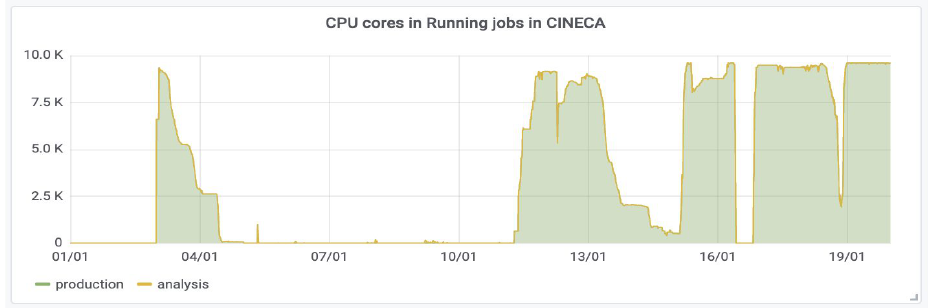
Fig. 3. Number of cores running for CMS in the period Dec19-Jan20. ​